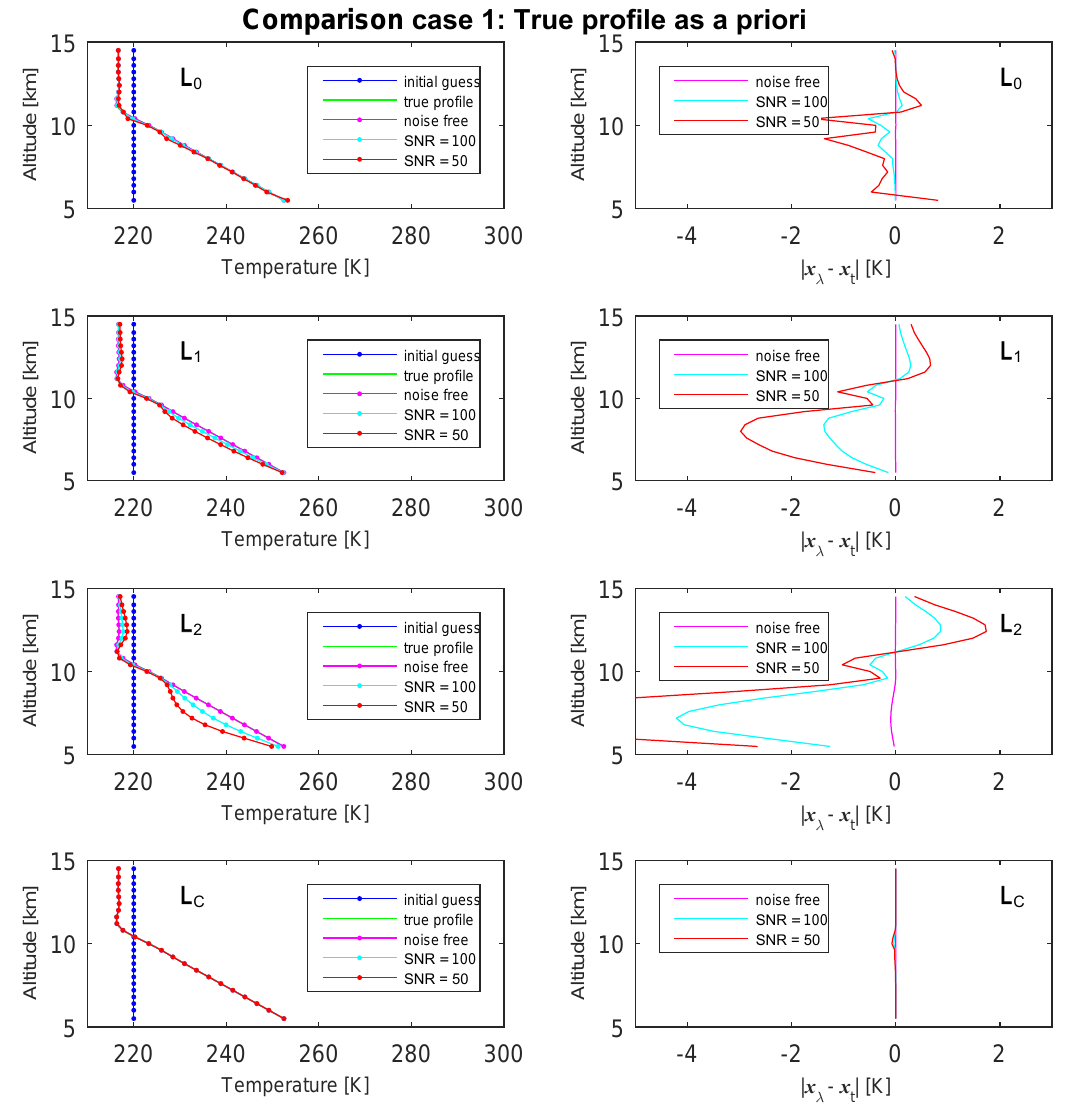
Figure 1. Comparison of temperature retrievals for case 1. The initial guess and true profile are blue and green lines, respectively. Retrieved temperature profiles ( left panel ) and the corresponding differences to the true profiles ( right panel ) are shown for the four regularization